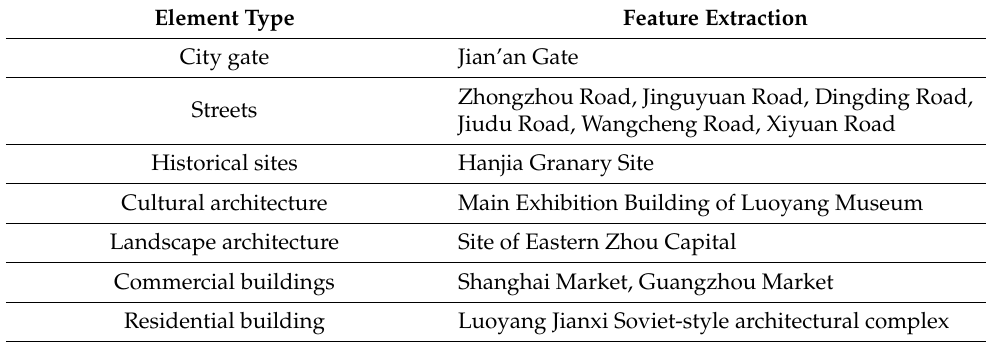
Table 4. Extraction of urban spatial elements in the urban industrialization